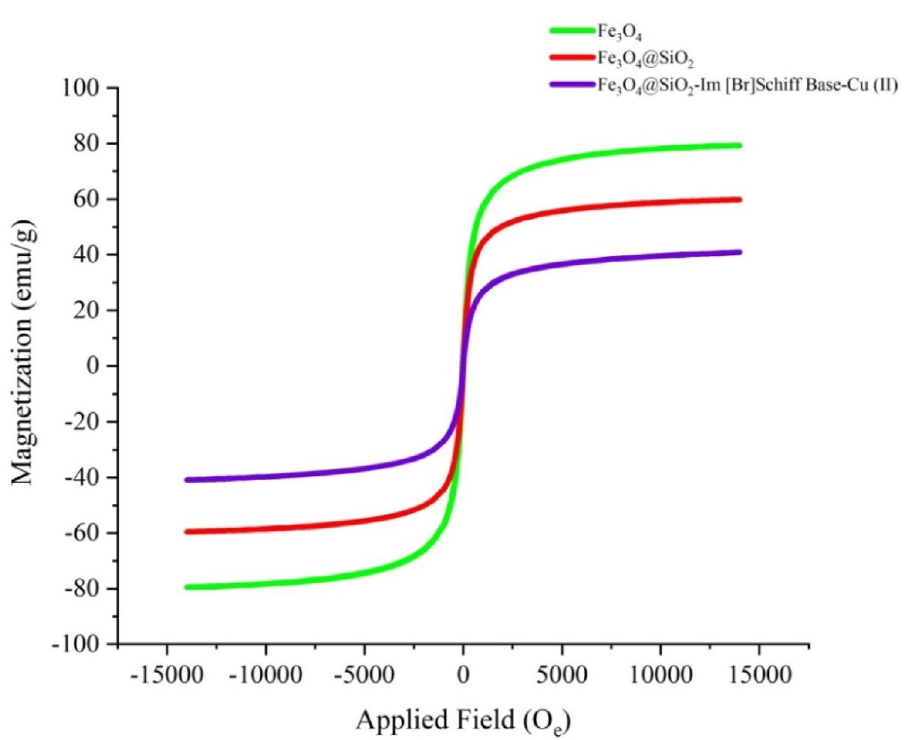
Figure 9. Magnetization curves of Fe 3 O 4 , Fe 3 O 4 @SiO 2 and Fe 3 O 4 @SiO 2 -Im[Br]-SB-Cu (II)